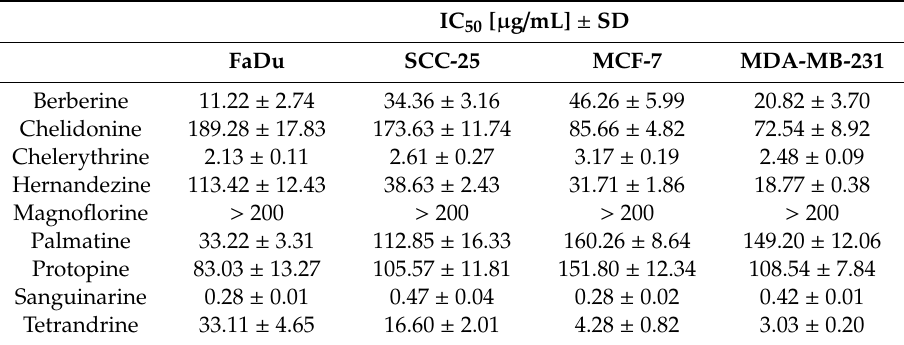
Table 2. Cytotoxic e ff ect of The investigated alkaloids against cancer cell lines (FaDu, SCC-25, MCF-7,